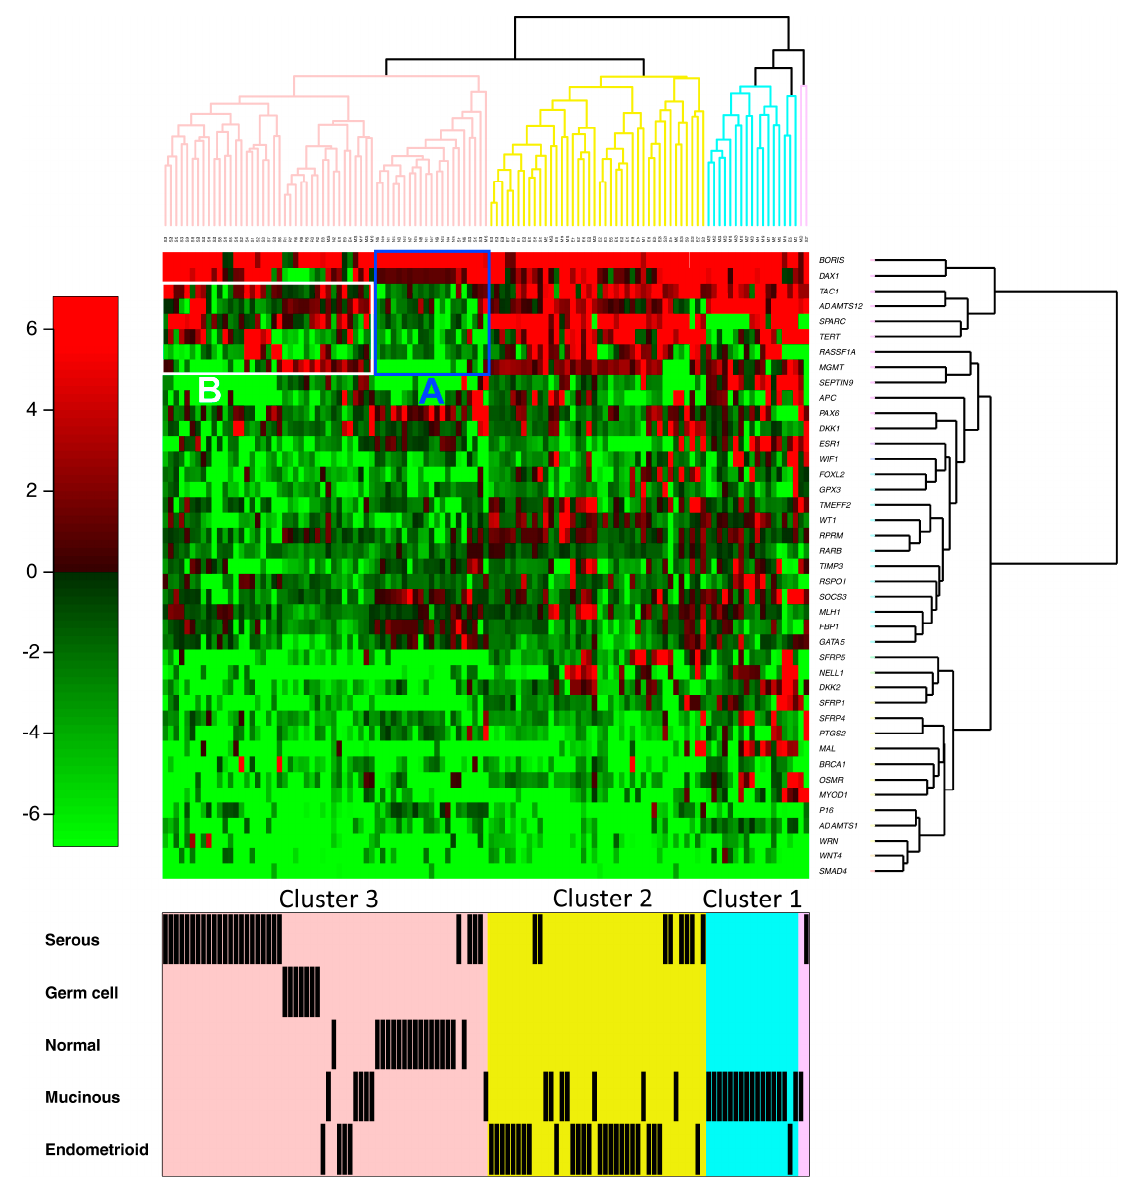
Figure 2. Hierarchical clustering of 41 differentially methylated gene promoters in 102 ovarian tumors and 17 normal ovarian tissues. The methylation levels (M-values) vary from 0 (0% methylation, green) to 1 (100% methylation, red). Cluster 1 (cyan); Cluster 2 (yellow); and Cluster 3 (pink, with groups A and B).